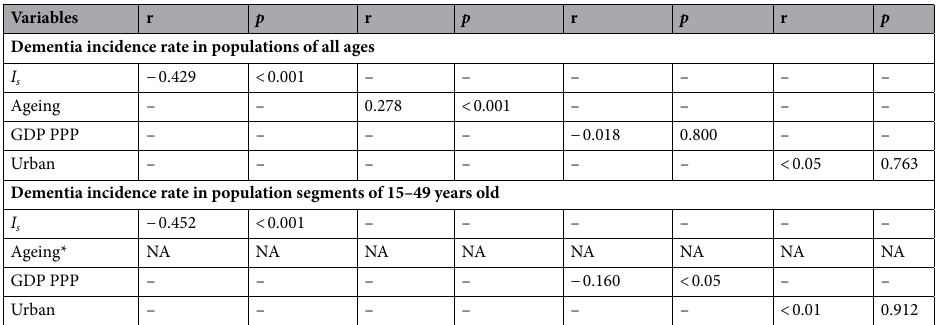
Table 2. Comparison of partial correlation coefficients between dementia incidence and each variable when the other three variables were kept statistically constant. Significance level: * p < 0.05; ** p < 0.01; *** p < 0.001; sample size range: 170 for all analyses. Data sources: Dementia Incidence expressed as the number of new onsets of Alzheimer’s disease and other dementias published by the Institute for Health Metrics and Evaluation (IHME) in 2020; I s measuring the magnitude of the opportunity for natural selection, extracted from the previous publication by You et al. https:// doi. org/ 10. 1111/ eva. 12523; Ageing expressed with life expectancy at 65 years old (2010–2015) published by the United Nations; GDP PPP expressed in purchasing power parity in 2015 US dollars published by the World Bank; Urbanization expressed in percent of population living in urban areas in 2015 published by the World